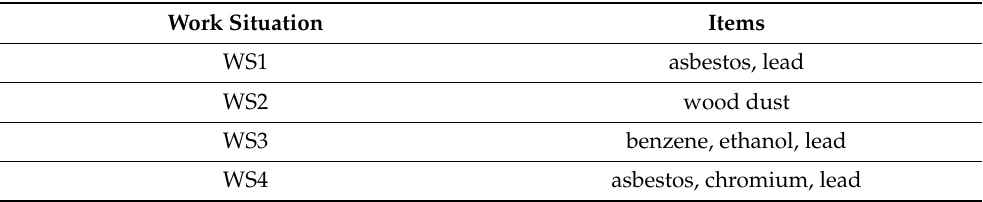
Table 1. Example of a transaction database format applied to work